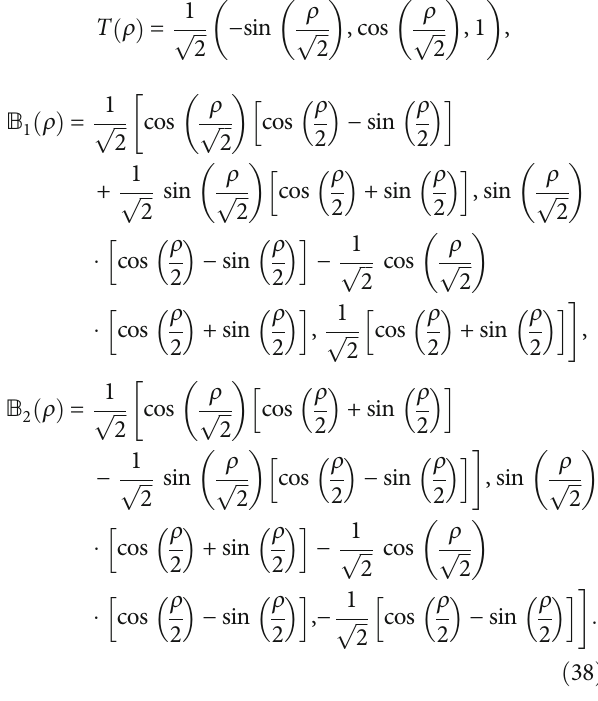
1 due to Darboux